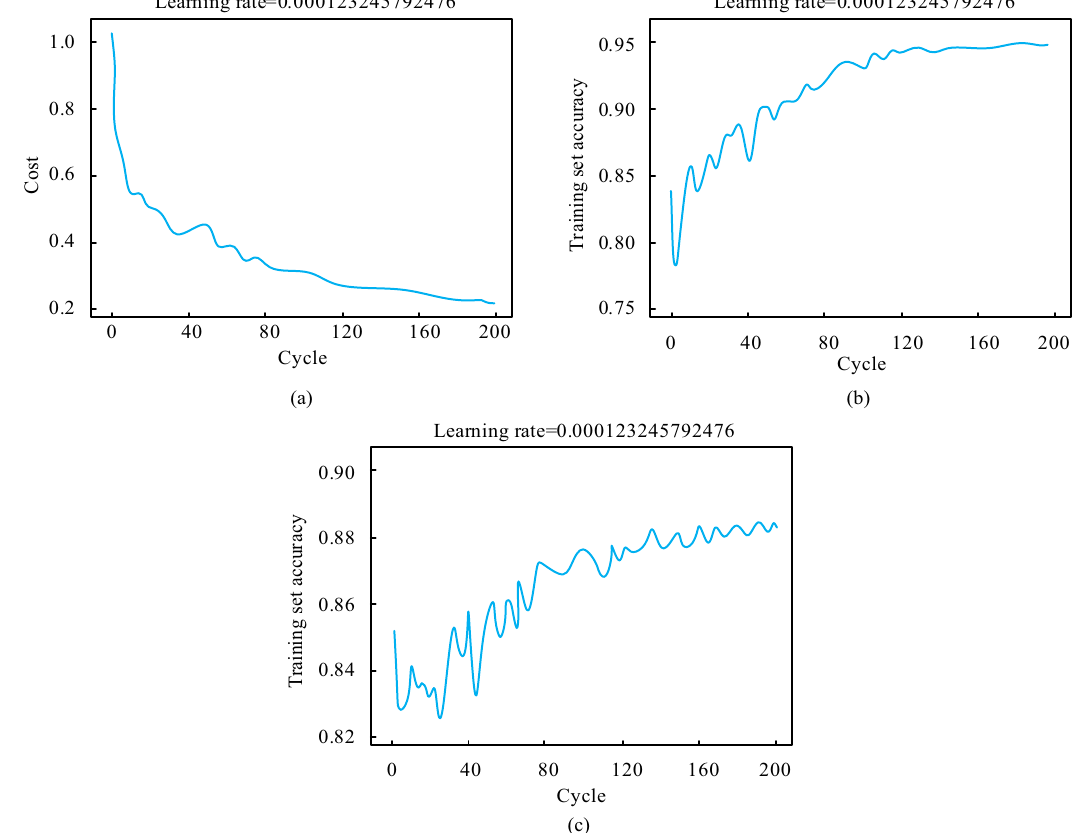
Figure 5: Cost and accuracy of the original dataset: ( a ) cost, ( b ) training set accuracy, and ( c ) validation set